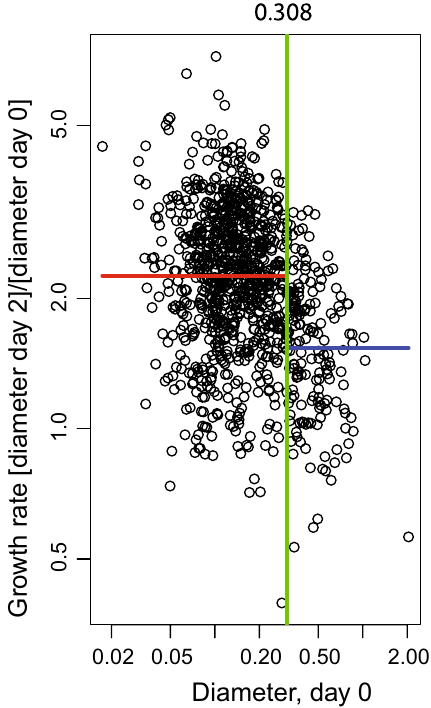
Figure 2. A standard change point analysis demonstrates that the growth rates of the MDCOs vary as a function of their size. A change point analysis at 308 µm was determined using all control APPK MDCOs. When the change point analysis was applied to all studies, only MDCOs < 308 µm on day 0 were used in the analyses (Suppl. Figs. S2–S6). The green line indicates the calculated change point value. The red line indicates the geometric mean of the data points that are lower than the determined change point value. The blue line indicates the geometric mean of the data points that are greater than the determined change point value (n =